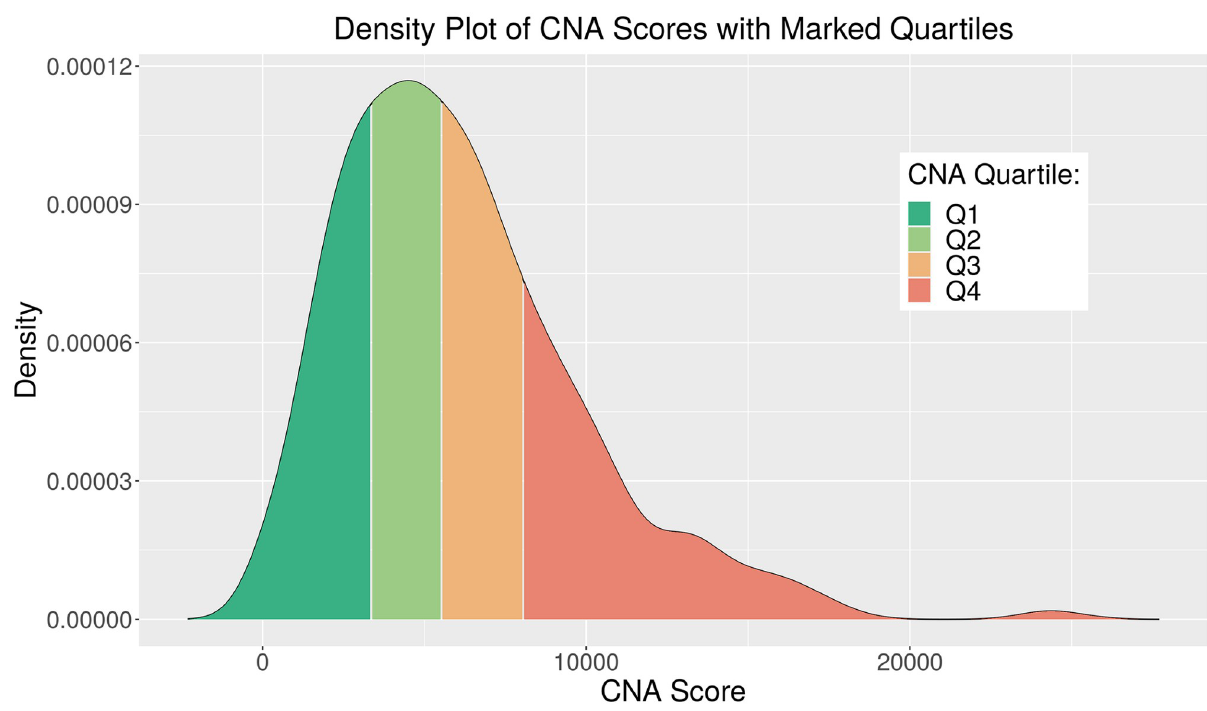
Fig 1. Density plot of CNA Score distribution for METABRIC luminal cases. CNA Quartiles 1-4 with threshold scores � 3335, � 5547 and � 8064 respectively, indicated by legend colours.